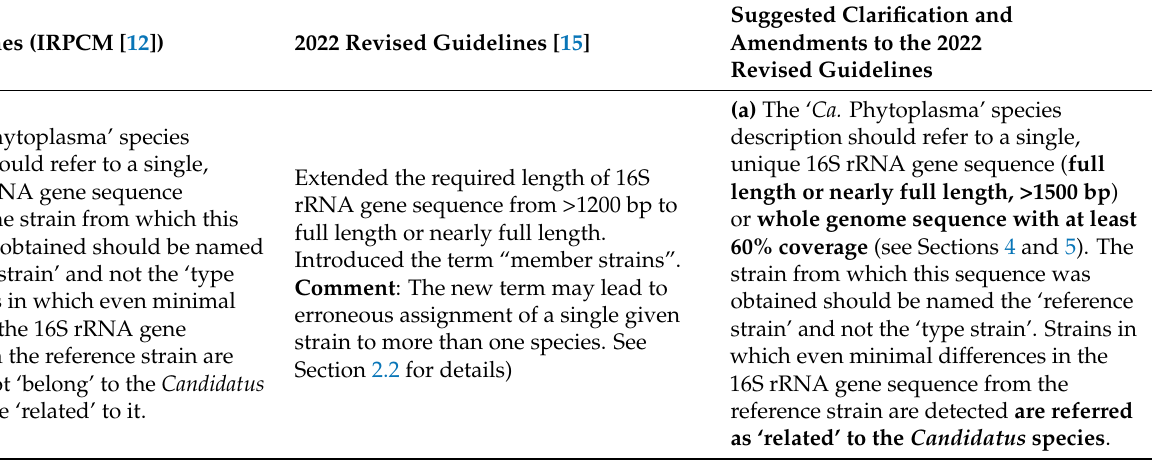
Table 2. A comparison of the 2022 revised guidelines and the 2004 original guidelines: issues require clarification and